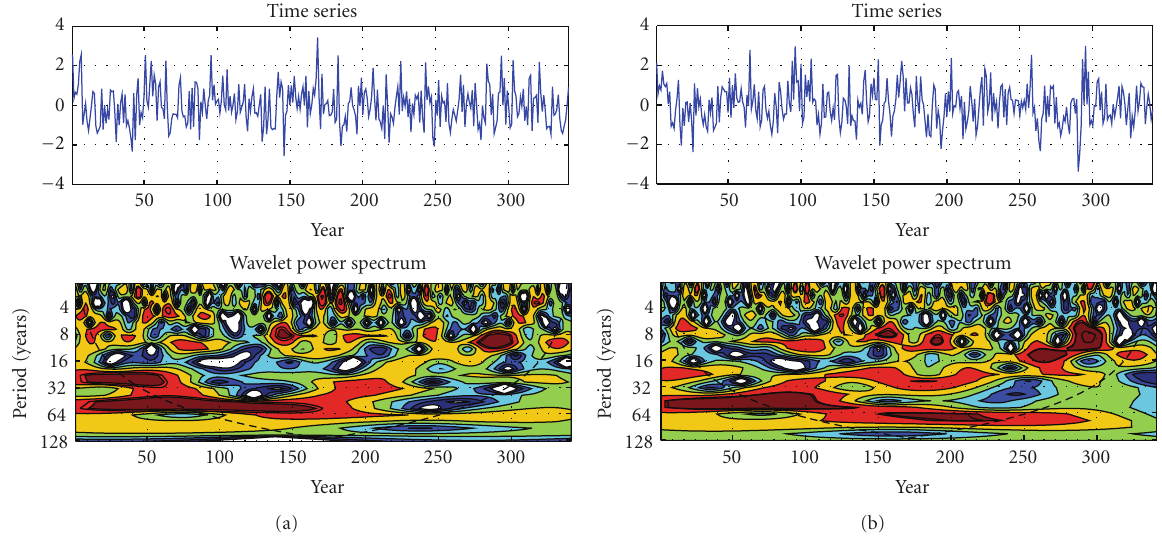
Figure 6: (a) Standardized time series of rainfall EOF1 for preindustrial run and wavelet (Morlet) analysis. (b) Standardized time series of index of south Atlantic SST defined as the average over the region 15 ◦ S–5 ◦ S, 330 ◦ E–345 ◦ E, and wavelet (Morlet) analysis. In the wavelet analysis, color indicates power in each frequency band and regions that are significant to 5% level are indicated by black solid lines. Values outside the dashed line are a ff ected by time boundaries. Wavelet software was provided by C. Torrence and G. Compo and is available at